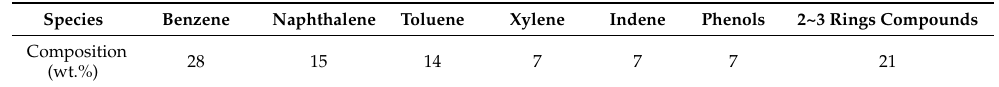
Table 1. Typical compositions of biomass tar [40]. Species Benzene Naphthalene Toluene Xylene Indene Phenols 2~3 Rings Compounds Composition (wt.%) 28 15 14